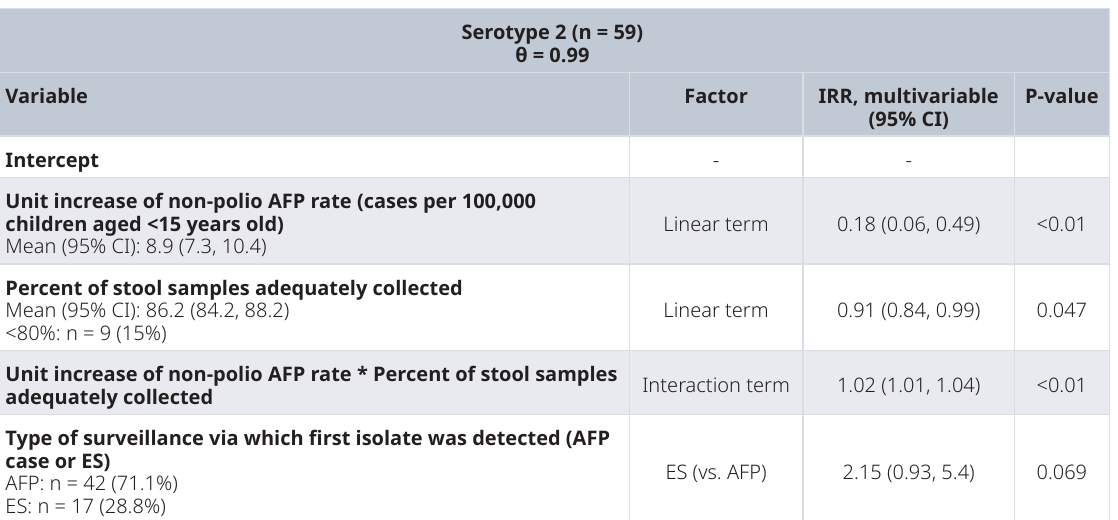
Table 2. Final regression model of factors associated with the number of nucleotide differences of the first isolate of vaccine derived poliovirus (VDPV) outbreaks. Sample size and dispersion parameter (θ) for the serotype 2 model are reported. AFP=acute flaccid paralysis; ES=environmental surveillance; IRR=incidence rate ratio; CI=confidence